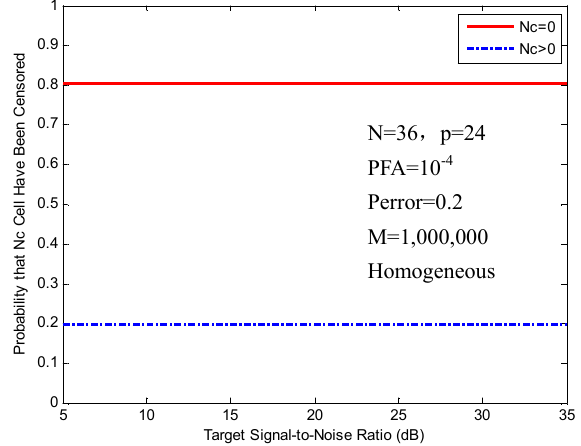
Figure 5. Probability of censoring in a homogeneous environment.